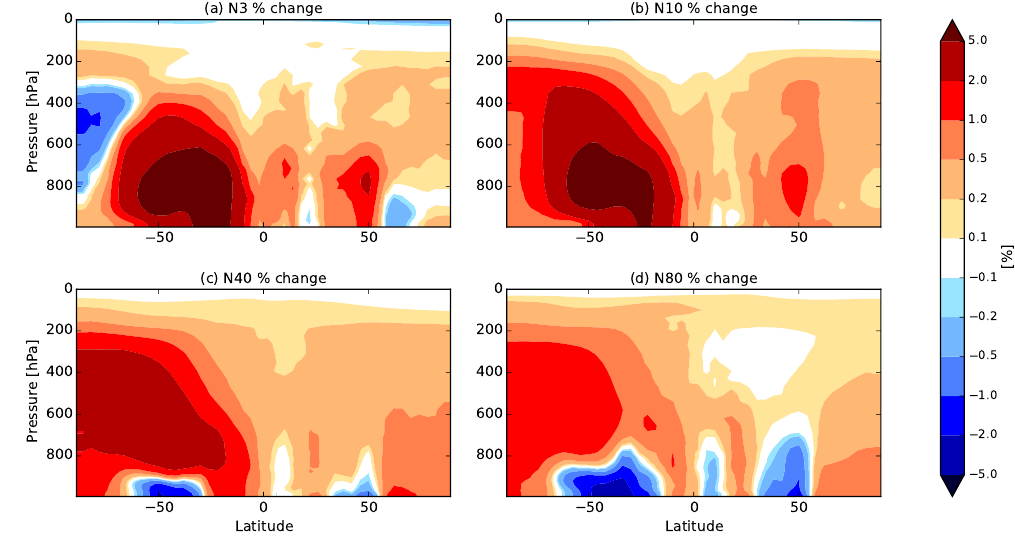
Figure 5. Zonal-mean annual-average percentage change in (a) N3, (b) N10, (c) N40, and (d) N80 when changing MEGAN BVOC emissions from year 1000 to year 2000 with constant present-day anthropogenic emissions (2005) (BE2.AE2.meg–BE1.AE2.meg). An increase in particle number concentration is represented in red, and a decrease in blue.